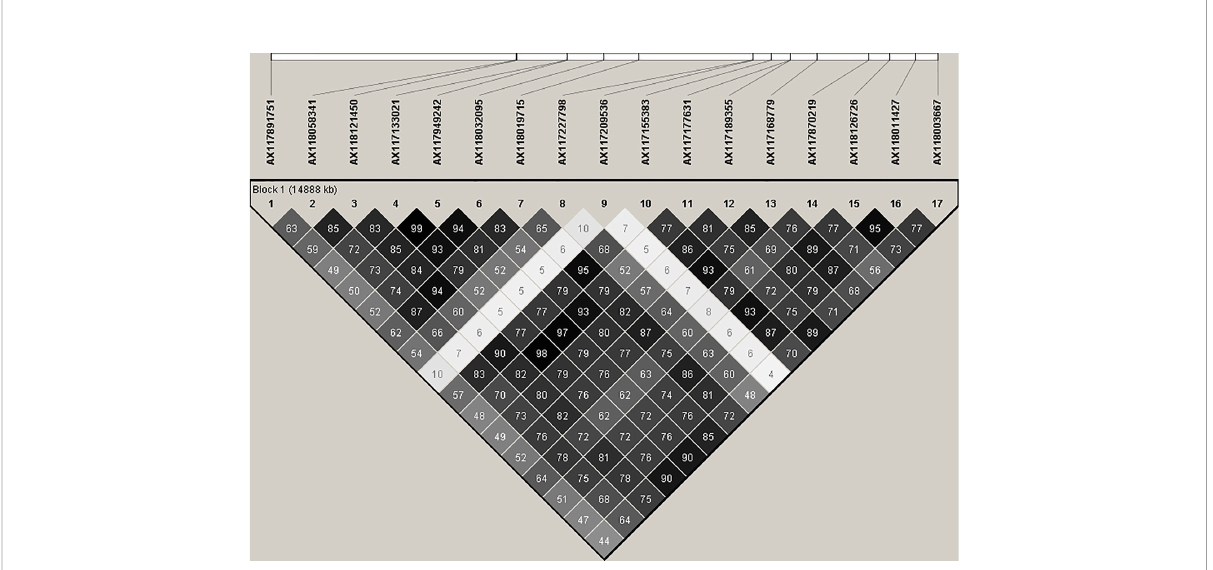
FIGURE 4 Linkage disequilibrium. r 2 (expressed as %) observed between 17 signi fi cant SNP markers, and physical alignment to the sorghum genome. These SNPs are closely linked on the sorghum genome and are signi fi cantly (P< 10 -7 ) associated with resistance to red